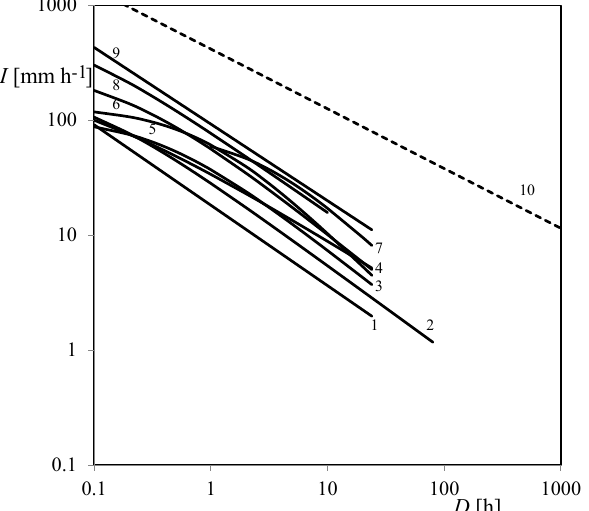
Figure 2. Rainfall intensity-duration (ID) thresholds. Numbers re- fer to case studies (Guzzetti et al., 2007). Very thick lines are global thresholds; thick lines are regional thresholds and thin lines are lo- cal thresholds. Black lines show global thresholds and thresholds determined for regions or areas pertaining to the central to eastern European region. Grey lines show thresholds determined for other regions or